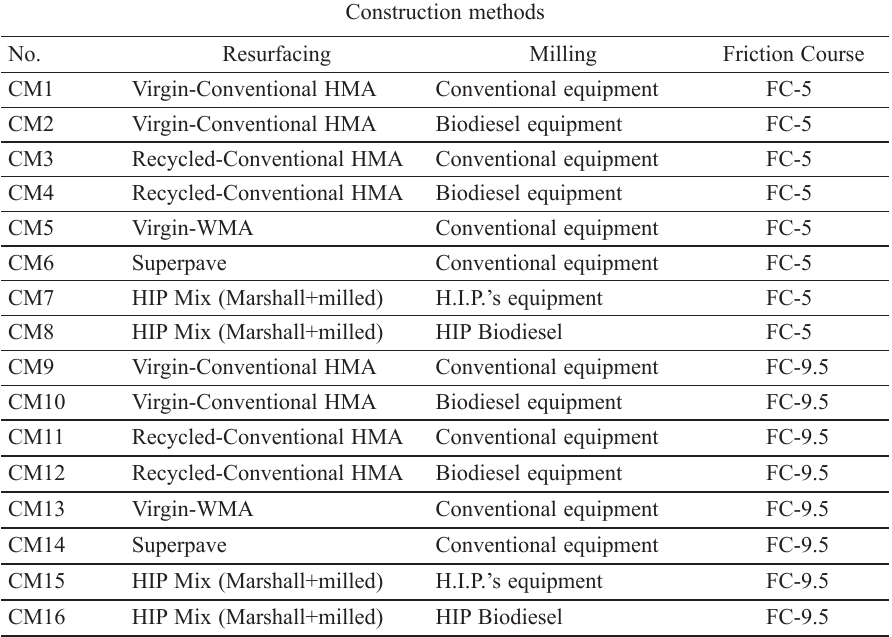
Table 10. Construction alternatives for resurfacing